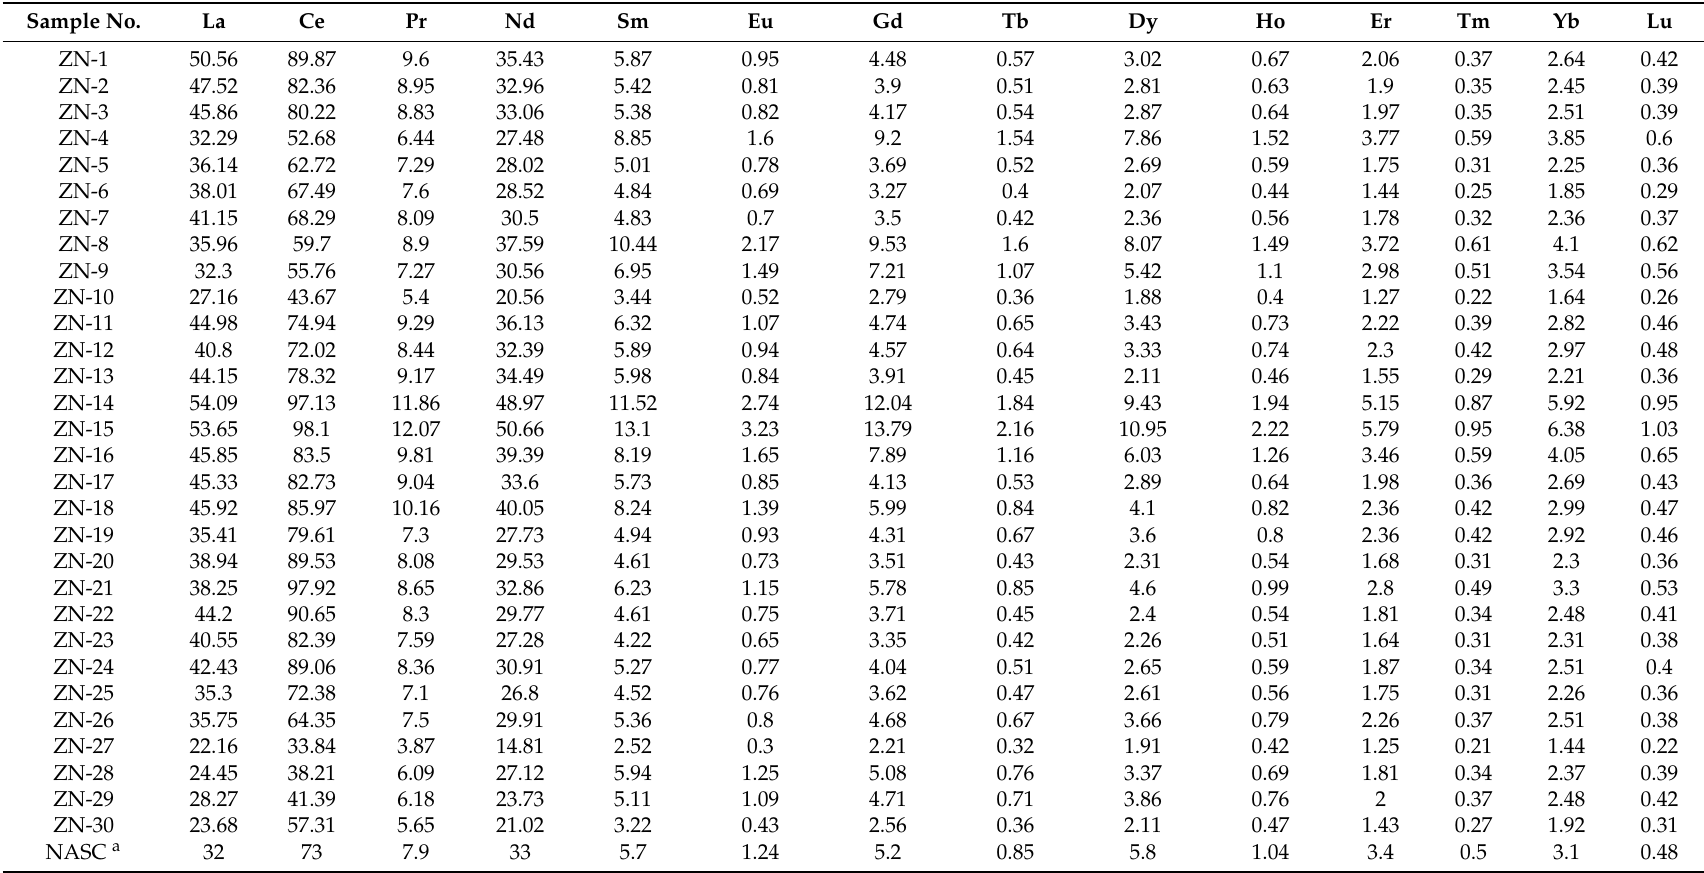
Table 4. REE concentrations (ppm) and calculated REE ratios of the 30 black rock series samples from Zhenning section. Sample